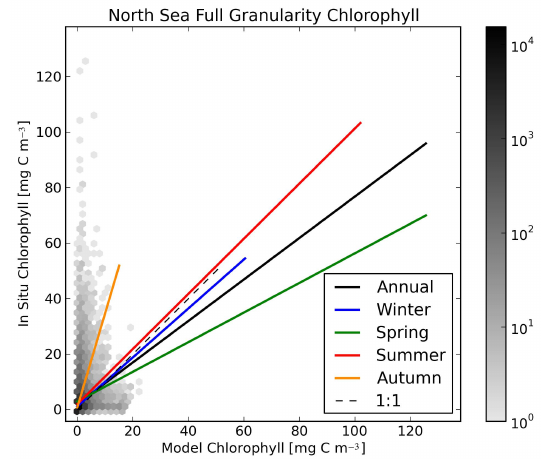
Fig. 10. Two-dimensional binned scatter plot of full granularity matched model data against in situ measurements for the North Sea chlorophyll. The solid coloured lines show the linear regression fits for the full annual and seasonal data, and the dashed line is the line of unity slope that passes through the origin. The shading of the binned data density plot is scaled such that darker hue indicates logarithmically higher data density.